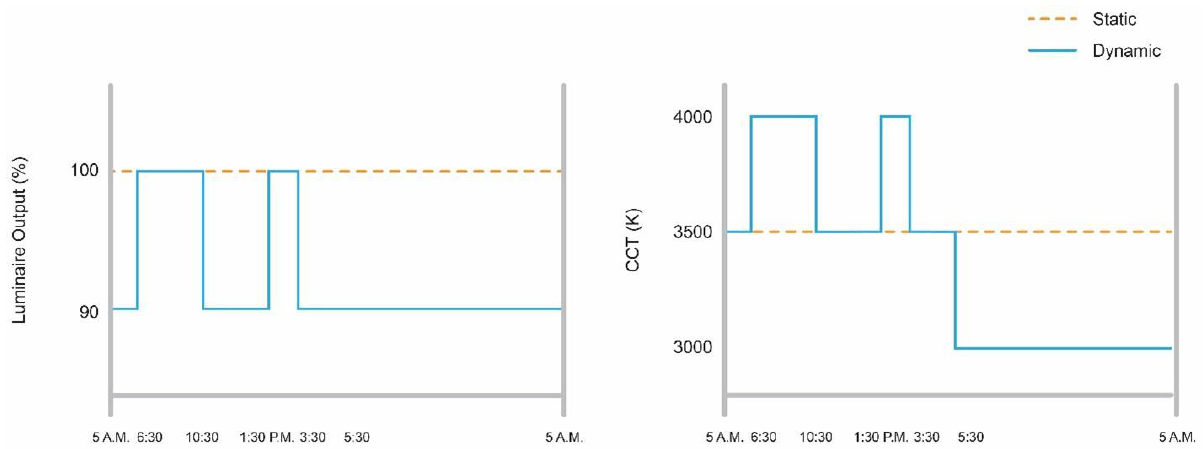
Figure 2. Dynamic and static lighting conditions in terms of Luminaire output (%) and CCT (K). Luminaire output varied between two settings (90% and 100%), and CCT varied between three settings (3000, 3500, and 4000 K). The office was used during typical daytime business